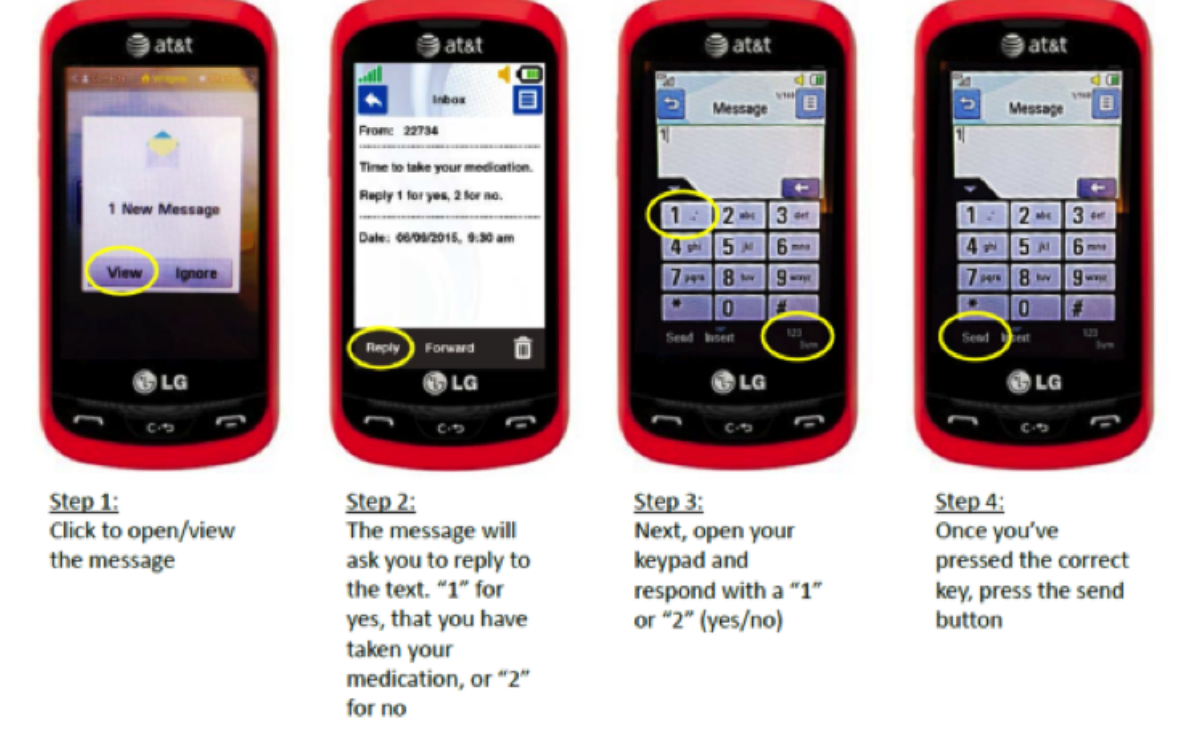
Figure 2. User-facing mobile health app instructions for the antiretroviral app reminder system (source: Care4Today Mobile Health Manager, Johnson & Johnson, New Brunswick, NJ).